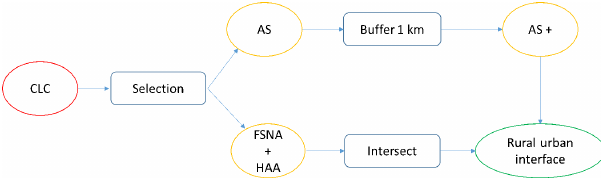
Figure 2. Framework implemented in the model builder (ArcGIS ™ ) to map the rural–urban interface. CLC: CORINE land cover; AS: artificial surfaces; FSNA: forest and semi-natural areas; HAA: het- erogeneous agricultural areas.